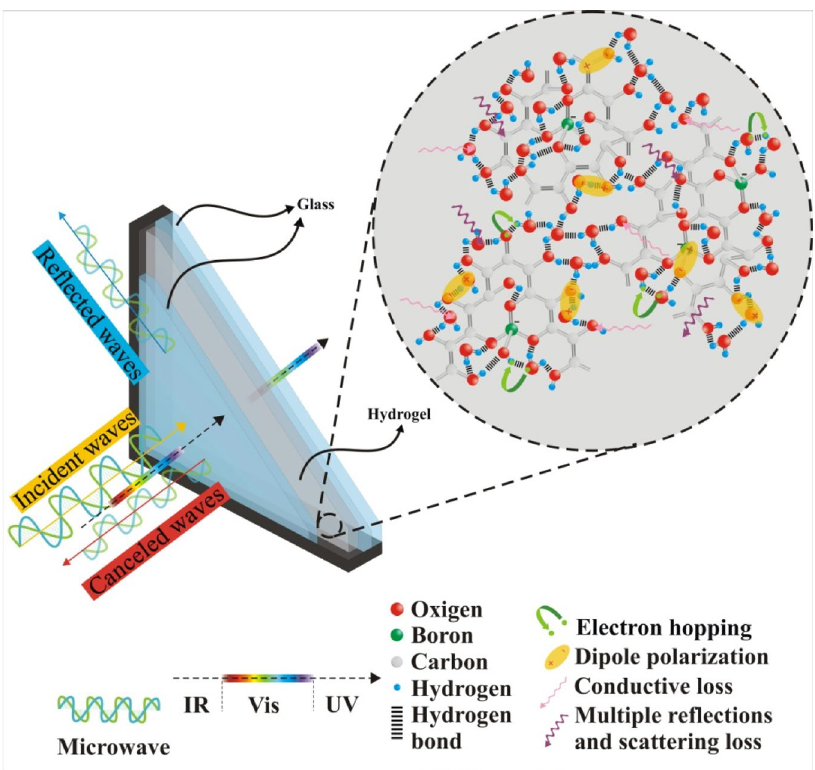
Figure 11. An illustrative diagram of the commanding mechanisms in the